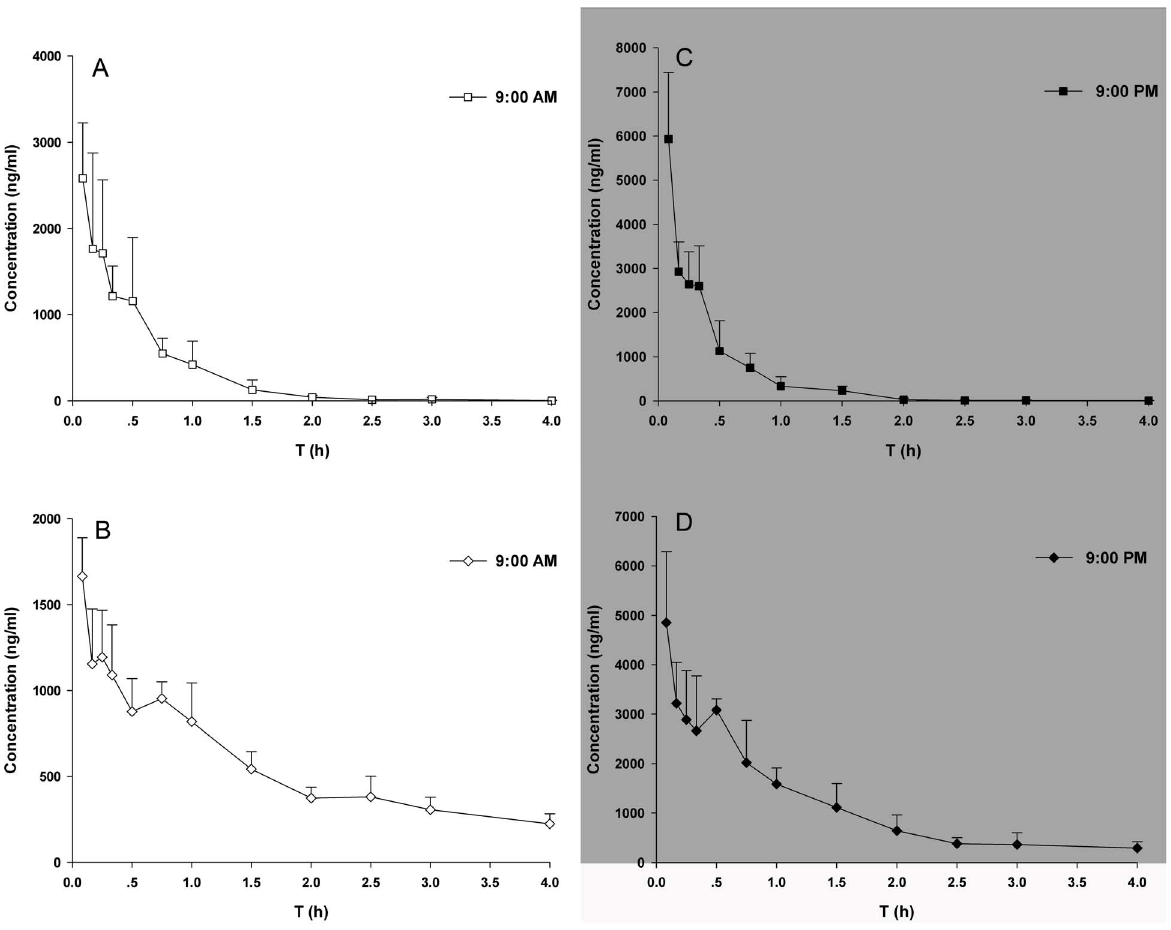
Figure 5. Plasma concentration-time profiles after meperidine injection (20 mg/kg, i.p.) at 9:00 am and 9:00 pm. ( A, C ) Plasma concentration-time profiles of meperidine at 9:00 am and 9:00 pm. ( B, D ) Plasma concentration-time profiles of normeperidine at 9:00 am and 9:00 pm. Each value represents the mean. (n=7). doi:10.1371/journal.pone.0102054.g005 9:00 pm. The plasma concentrations of pethidine and norpethi- dine during the light and dark phases displayed significant dosing time dependence. The pharmacokinetic parameters for each pethidine (Figure 5: A and C) and norpethidine (Figure 5: B and treatment–time group are presented in Table 1. As shown, the D) after a single i.p. pethidine injection (20 mg/kg) at 9:00 am or